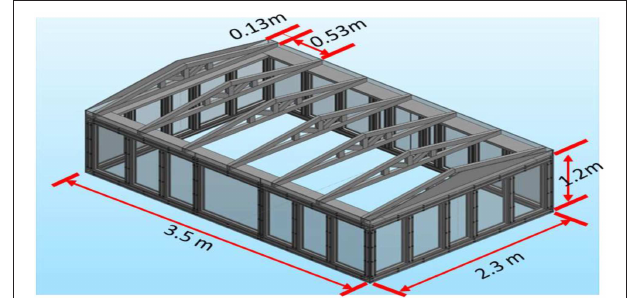
FIGURE 4 | Isometric view of building model.